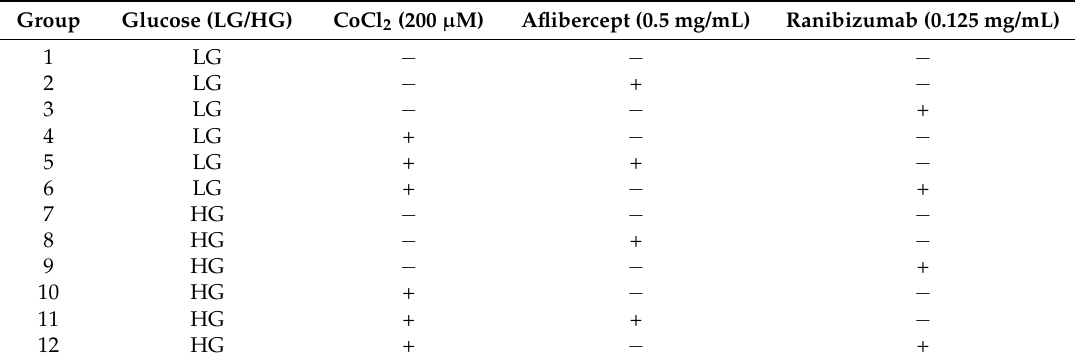
Table 1. Stress conditions in which 1% FCS starvation media were used to test the effects of anti-VEGF therapy on MIO-M1 Müller cells and Y79